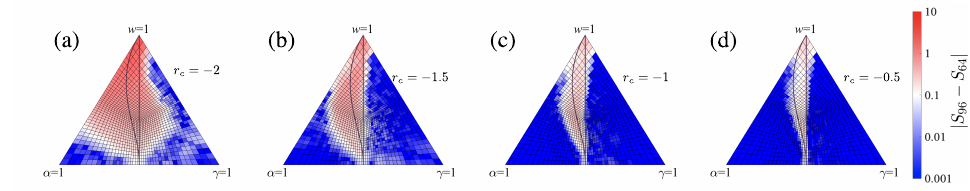
− ¯ S | in the partially post-selected model in Eq. (20) Figure 5: Density plot of | ¯ S 96 64 = − 2, (b) r = − 1.5, (c) r = − 1, (d) r = − 0.5. Full black line corre- with (a) r c c c c spond to the phase boundaries obtained from non-Hermitian dynamics (cf. Eq. (17)). The distinct phases of trivial area-law,topological area-law, and volume-law scaling are continuously deformed from the full measurement limit (a) to the strongly post- − ¯ S selected limit (b). The phase boundaries from the sharp crossover of ¯ S agree 96 64 well with the analytical predictions in the limit of strong post-selection [ cf. panel (c) ]